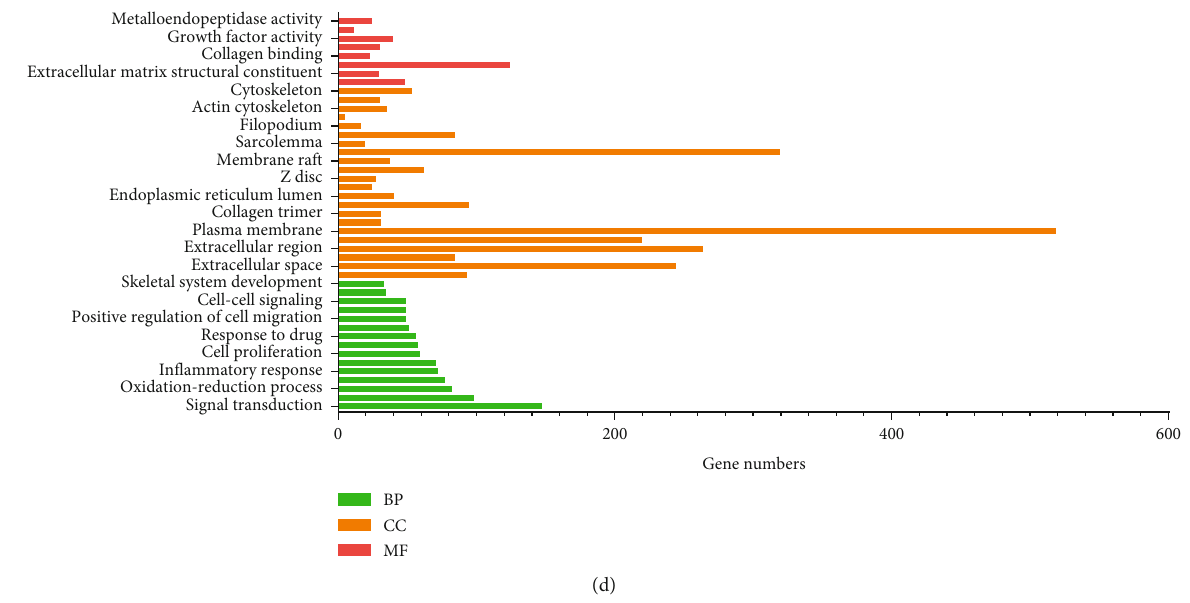
Figure 2: The 3D culture of GMSCs caused signi fi cant alterations in gene expression. (a) The di ff erence of gene expression between 2D- GMSCs and 3D-GMSCs was analyzed by RNA sequencing. (b, c) The representative global view of gene expression changes between 2D- GMSCs and 3D-GMSCs. (d) Gene ontology analysis of di ff erentially expressed genes. BP: biological process; CC: cellular component; MF: molecular